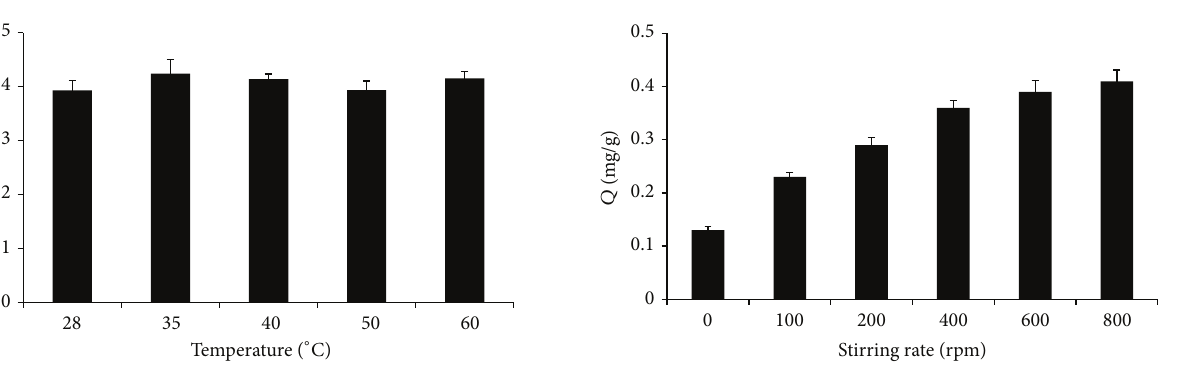
Figure 4: Effect of stirring rate on the extraction efficiency ( 𝑄 ) of Sr 2+ . Extraction conditions: absorption time 20min, pH 7, and 35 ∘ C.